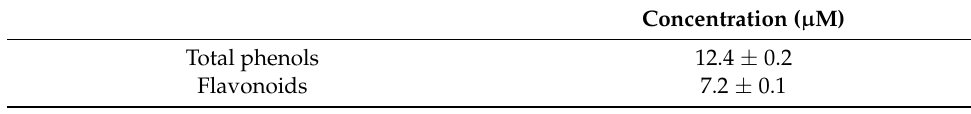
Table 1. Total phenols and flavonoids concentration present in 0.05% Ro .